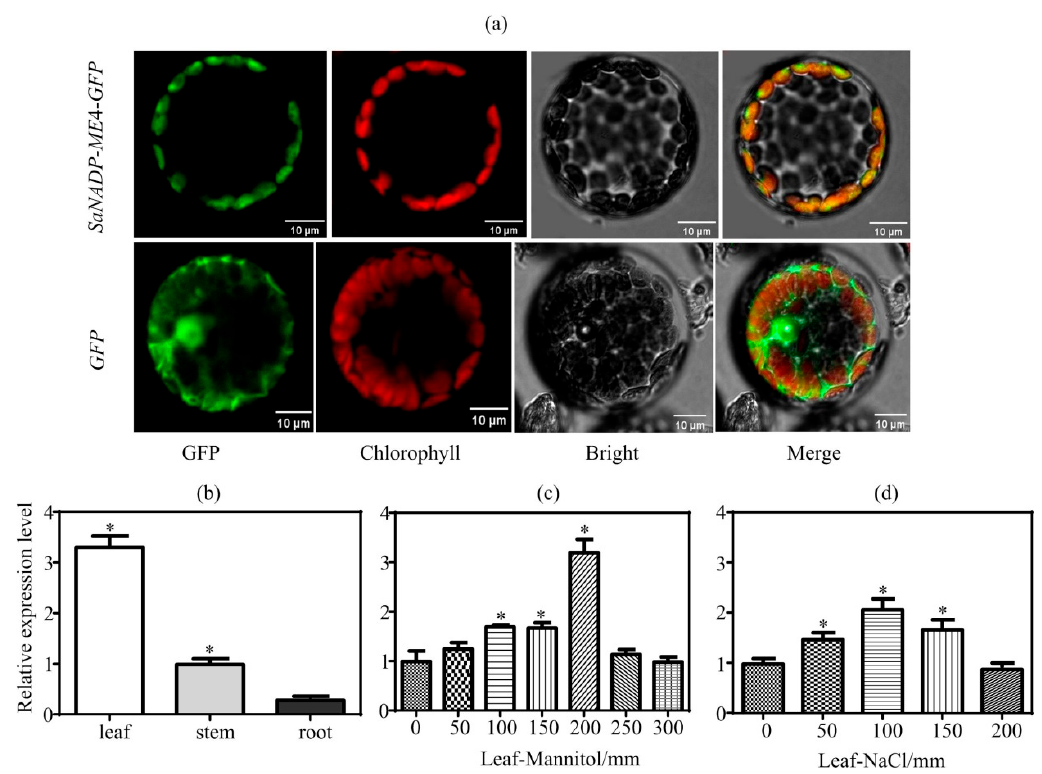
Figure 2. Subcellular localization of SaNADP-ME4 and its expression in Salsola laricifolia . ( a ) S ubcellular localization of SaNADP-ME4 in Arabidopsis protoplasts. Arabidopsis protoplasts isolated from 3-week-old leaves and transiently transformed with the 35S: SaNADP-ME4-GFP construct or the 35S: GFP as a control were analyzed by 16 h post transformation. Green and red fluorescence are indicative of the localization of the GFP protein and the chlorophyll, respectively. The images present GFP localization, chlorophyll localization, bright field, and a merge of the first three images. ( b ) The relative expression of SaNADP-ME4 in leaves, stems, and roots of S. laricifolia based on RT-qPCR. The relative expression in other tissues was normalized by that in stems, which was set to 1.0. The samples were collected from 2-month-old S. laricifolia plants at 2 h after the beginning of a photoperiod. The Sa18S of S. laricifolia was used as a suitable reference gene for RT-qPCR in different tissues. ( c , d ) Expression analysis of SaNADP-ME4 in the leaves of S. laricifolia under different levels of mannitol ( c ) and NaCl ( d ) stresses based on RT-qPCR. The relative expression in stress conditions was normalized by that in control condition, which was set to 1.0. Two-month-old plants were chosen. All treatments started at 2 h after the beginning of a photoperiod and lasted for 4 h. The SaEF1- α of S. laricifolia was used as a suitable reference gene for RT- qPCR in mannitol and salt stresses. Values are means ± SD (standard deviation). Asterisk indicates a significant difference at the p < 0.05 significance level, as determined with SPSS v. 19.0.